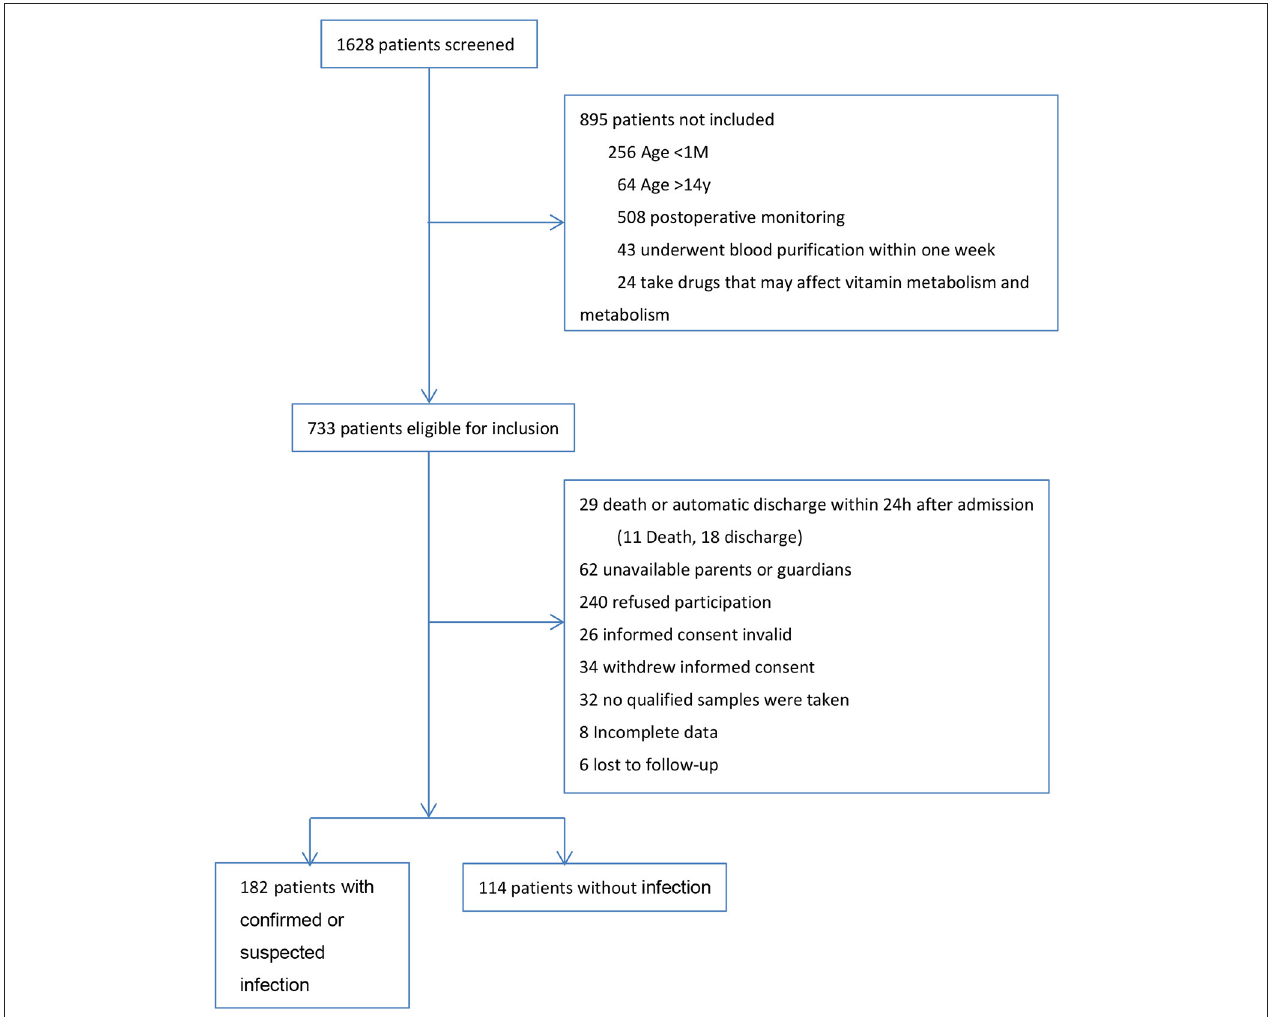
FIGURE 1 | Research